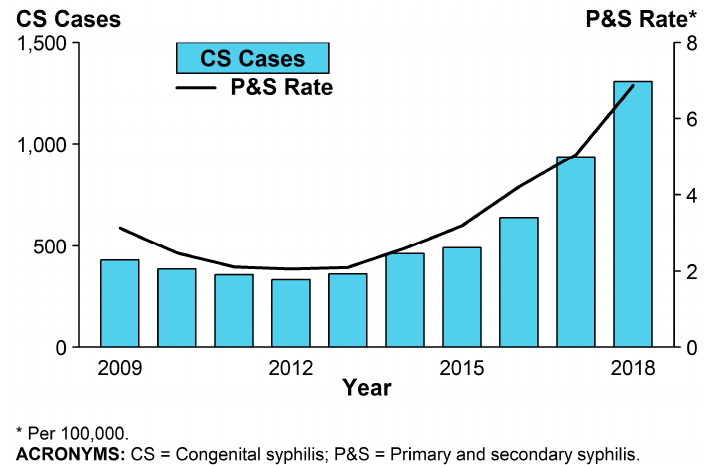
Figure 1. Reported cases by year of birth and rates of reported cases of primary and secondary syphilis among females aged 15–44 years, United States, 2009–2018, adapted from the Centers for Disease Control and Prevention (CDC) Sexually Transmitted Disease Surveillance 2018